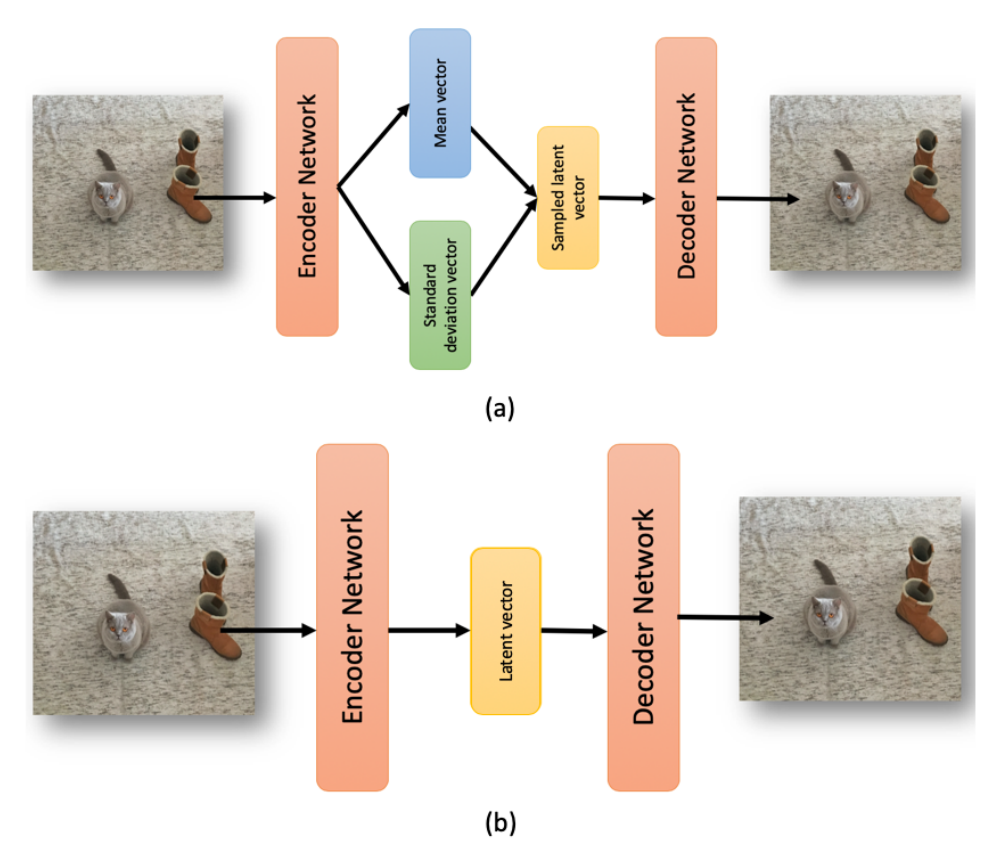
Figure 1. In ( a ), a Variational AutoEncoder (VAE) scheme with the mean and standard deviation layers used to sample the latent vector. In ( b ), the vanilla autoencoder with a simple latent vector.